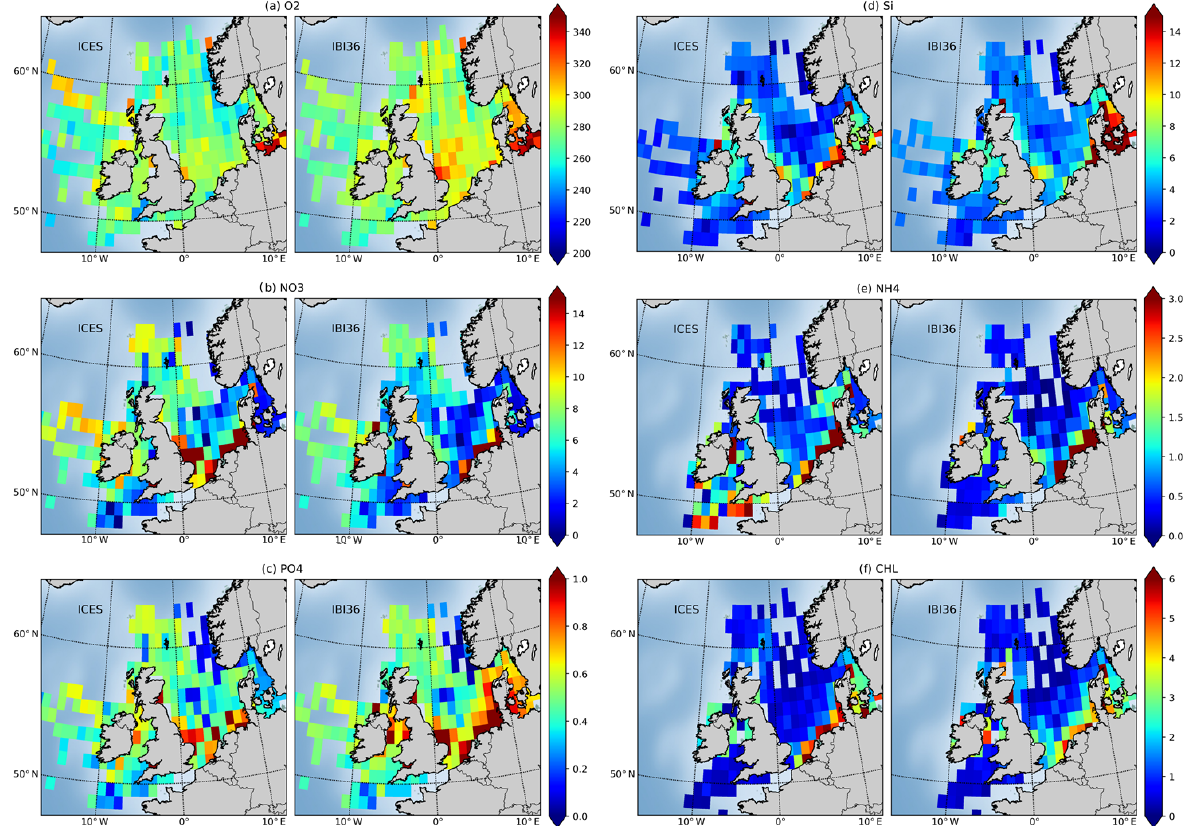
Figure 9. Surface concentrations of (a) oxygen, (b) nitrate, (c) phosphate, (d) silicate, (e) ammonium and (f) Chl a from ICES database (left of each panel) and IBI36 (right of each panel). Oxygen and nutrients are expressed in µmolL − 1 and Chl a in mgChlm − 3 . Daily averaged IBI36 outputs and ICES data are collocated in space and time between 2010 and 2016. Match-ups are averaged between 0 and 10m depth, gridded and averaged on a horizontal grid of 1 ◦ × 1 ◦